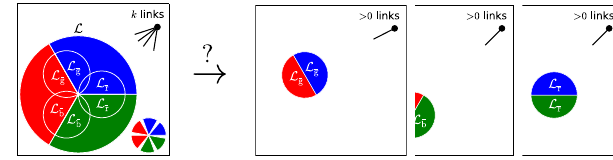
FIG. 8. We have to calculate the probability, if a node with k links is, for every color c , connected to the giant component L ¯ c with deleted color c . All connections over at least one link have to exist at the same time. We illustrate this question with red ( c ¼ r), green ( c ¼ g), and blue ( c ¼ b). If a link connects to LL ¯ , it g definitely does not connect to L ¯ for one of the other colors. This c kind of dependence forces us to use a stepwise calculation with conditional